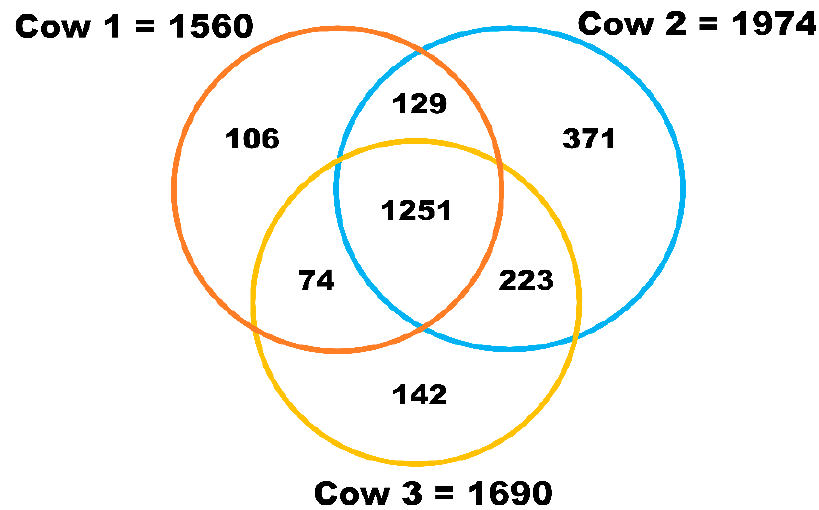
Figure 2. Proteomic analysis of milk sEVs. The Venn diagram displays the number of identified proteins in milk sEVs.